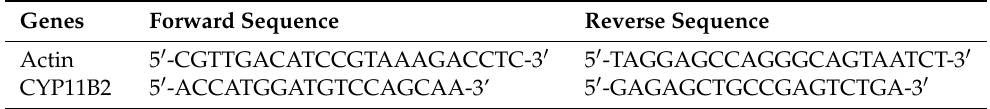
Table 2. Primers used for the PCR